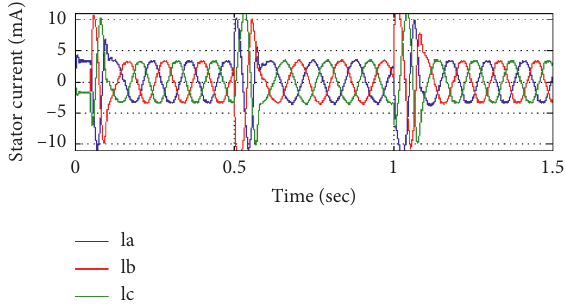
Figure 20: Stator current at motoring and regenerating modes.